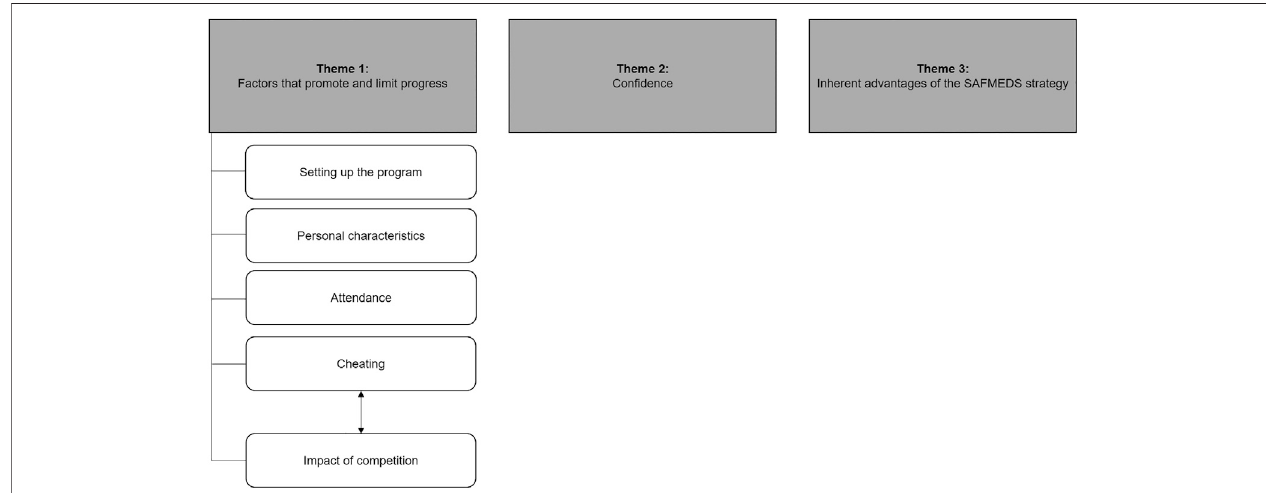
FIGURE 1 | Thematic map of the themes within the online survey